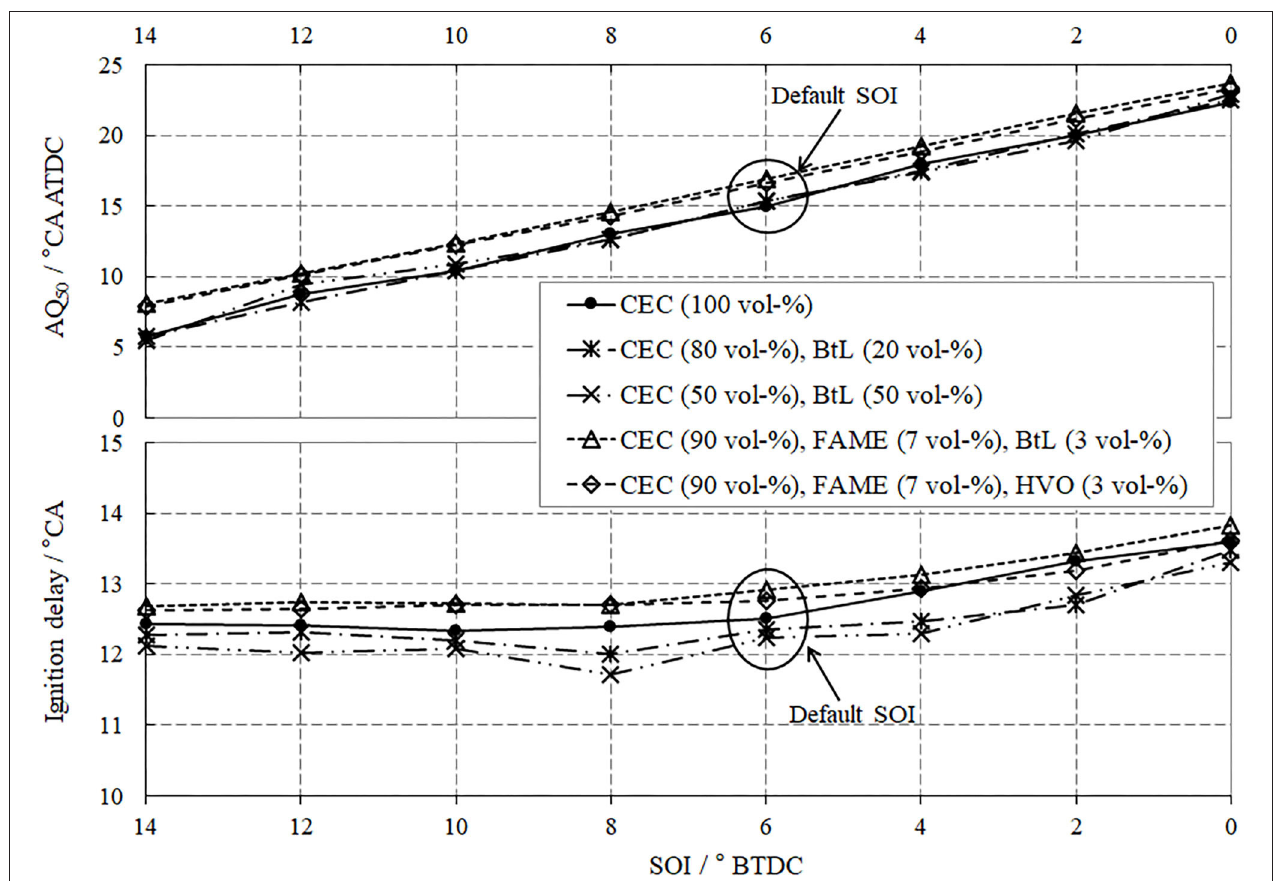
FIGURE 11 | AQ 50 and IGD at 3,000 min − 1 and 8 bar BMEP with varying